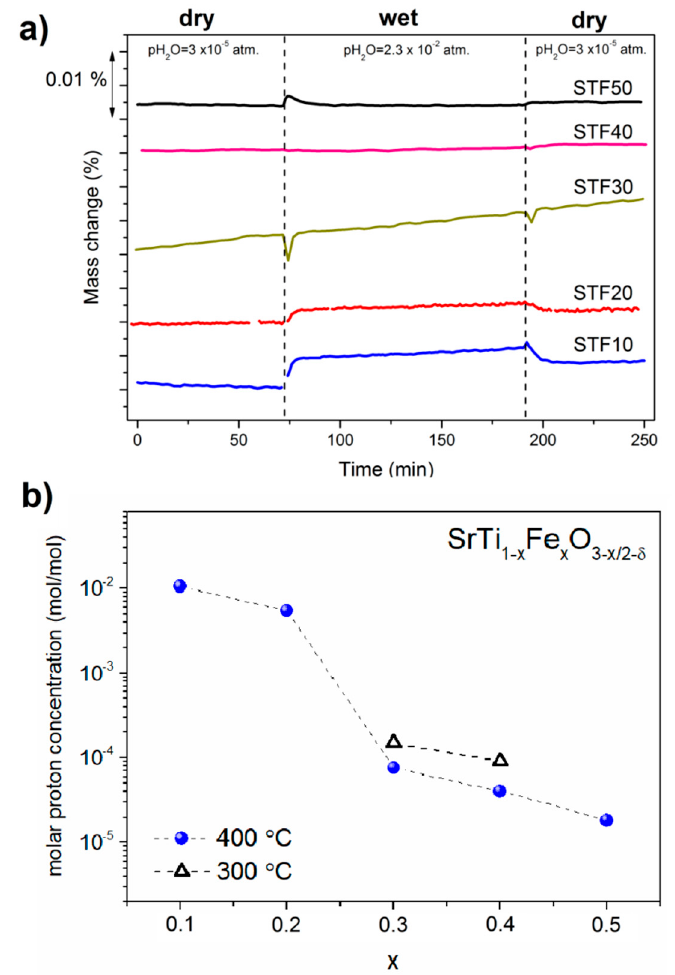
Figure 6. ( a ) Mass change recorded at the isothermal switch at 400 ◦ C between dry (pH 2 O ≈ 3 × 10 − 5 atm.) and humidified air (pH 2 O = 0.023 atm.); (b) proton concentration at 400 ◦ C and 300 ◦ C versus